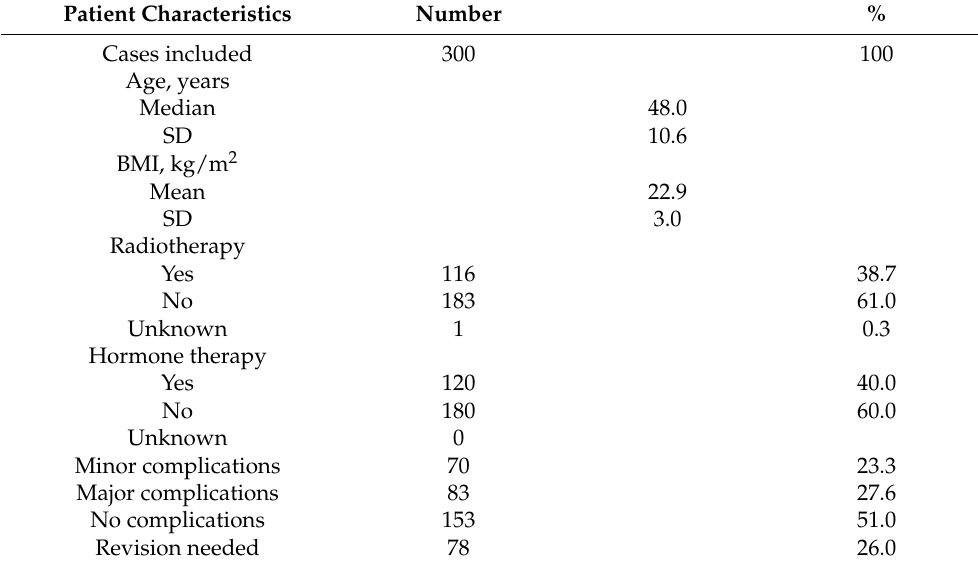
Figure 3. 3 months postop picture. The patient denied further small esthetic corrections with lipofilling and nipple-areola reconstruction and was fully satisfied with the result. Table 2. Patient